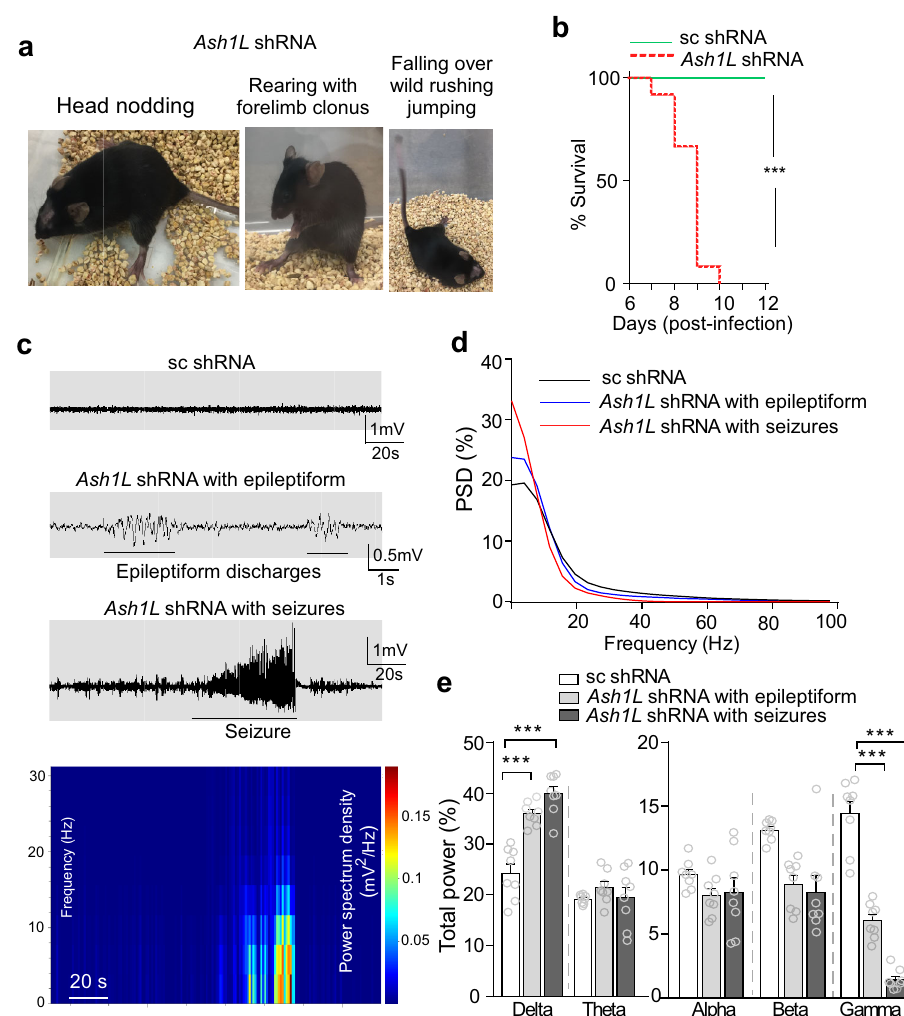
Fig. 5 Ash1L de fi ciency in PFC induces epileptic seizures and mortality. a Snapshot pictures showing Ash1L shRNA-infected mice with seizures at different stages based on the Racine seizure behavior scoring paradigm. b Survival curves showing the mortality rates in mice infected with scrambled shRNA vs. Ash1L shRNA AAV. n = 20 mice(10 M,10 F)/group, *** p < 0.001, Mantel – Cox test. c Representative EEG traces from mice with PFC injection of scrambled shRNA or Ash1L shRNA AAV showing epileptiform discharges or seizures (high-frequency, high-voltage, rhythmic activity with clear onset, progression, and termination). Bottom: Spectrogram showing the frequency and power density (color scale, blue: 0; red: 0.2 mV2/Hz) before, during, and after seizures. d , e Comparison of total power spectral density (PSD, d ) and the relative power in each EEG frequency band ( e ) between mice infected with scrambled shRNA vs. Ash1L shRNA AAV. EEG band: Delta (0.1 – 4 Hz), theta (4 – 8 Hz), Alpha (8 – 13 Hz), beta (13 – 30 Hz), and gamma (30 – 60 Hz). n = 8 mice(4 M,4 F)/group, *** p < 0.001; ** p < 0.01, two-tailed t test. Data are presented as mean values ± SEM. Detailed statistical data are provided in a Source Data fi